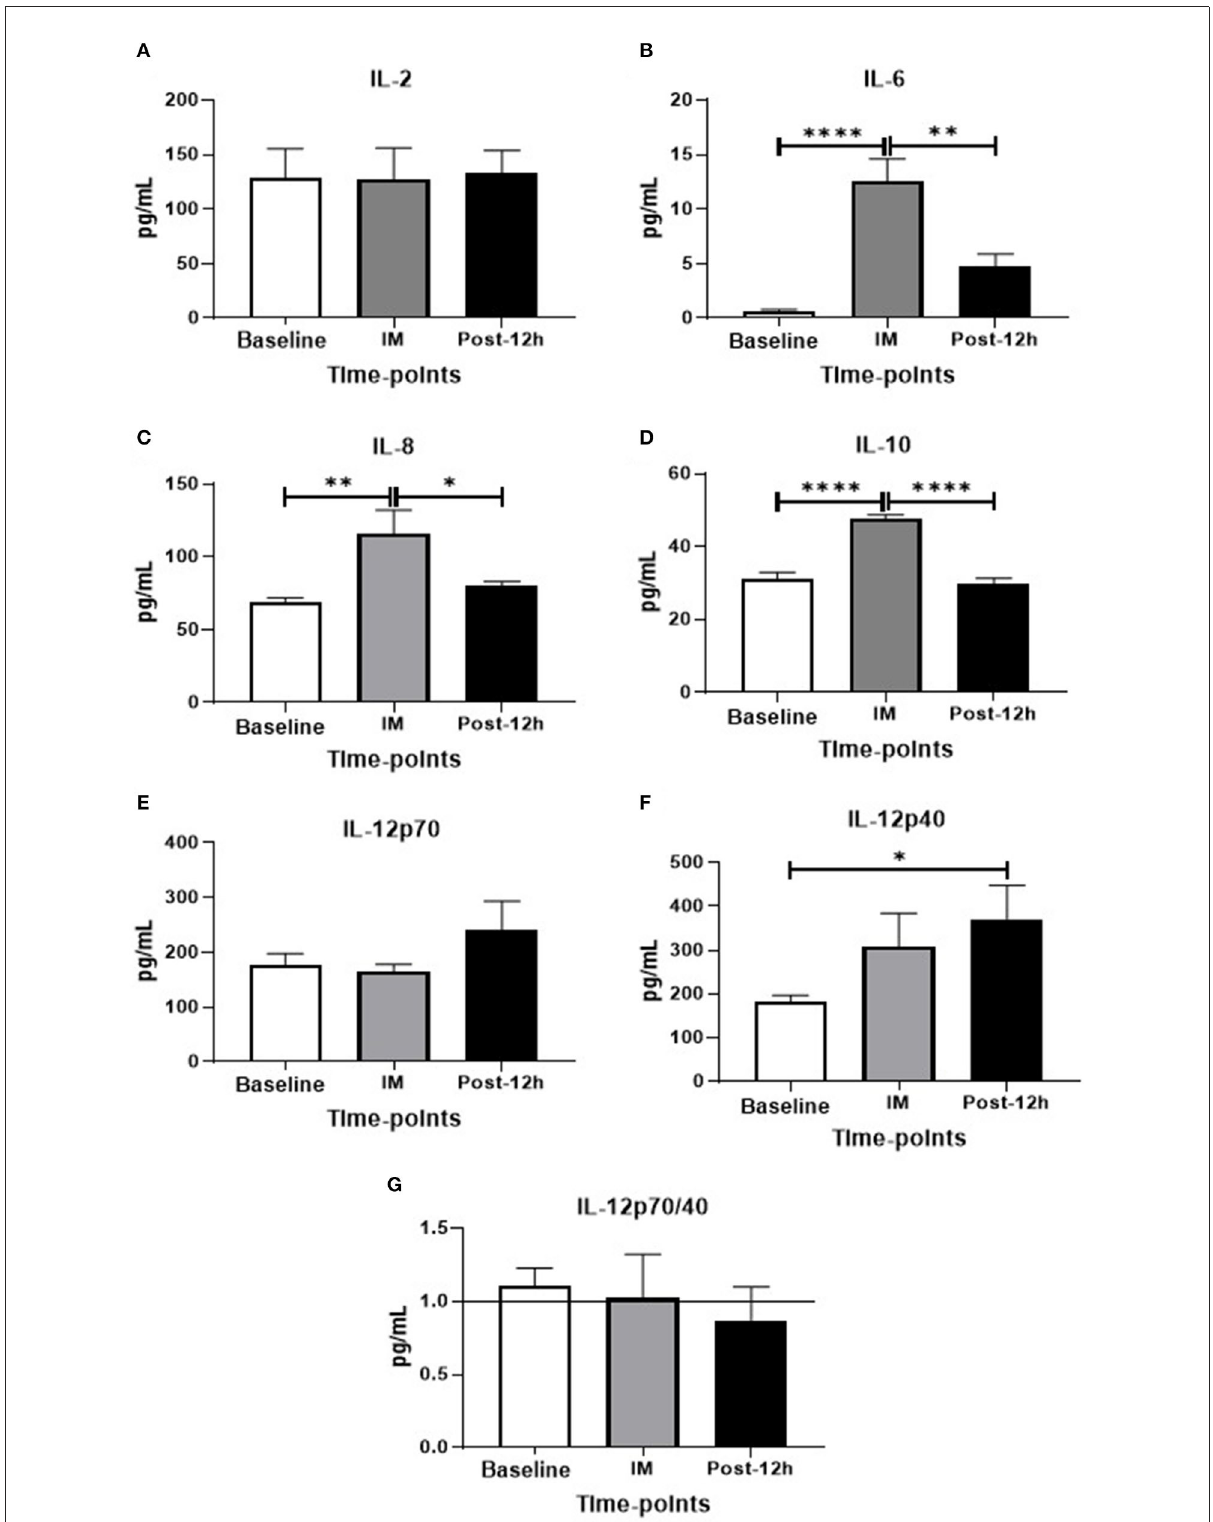
FIGURE2 (A–G) Levels of plasma cytokines in different time-points: * p < 0.05, ** p < 0.01, *** p < 0.001, **** p <